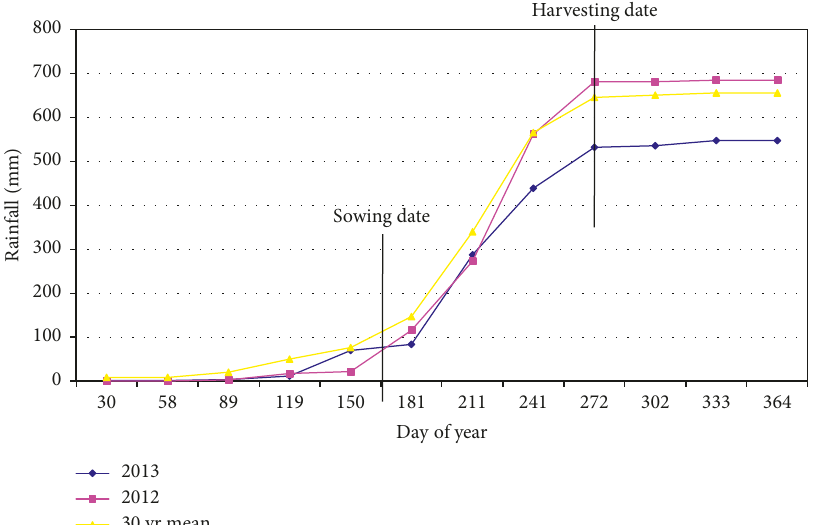
Figure 1: Cumulative rainfall across the two cropping seasons (2012 and 2013) and average of 30 years for the trial site in the Dura area, northern Ethiopia.